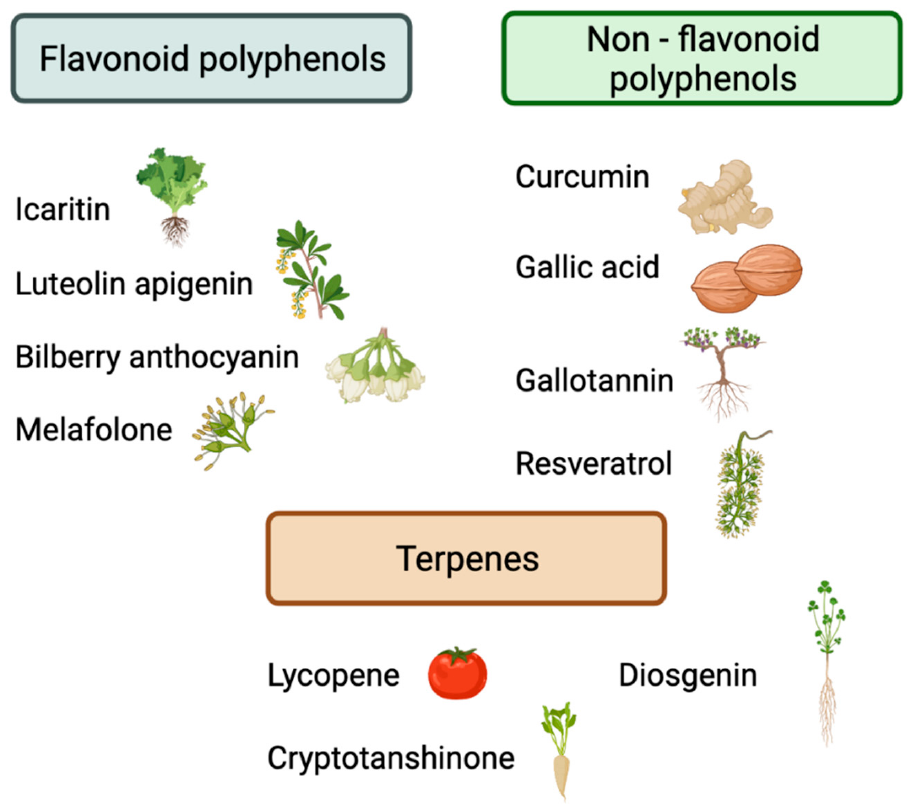
Figure 2. Schematic figure reporting the main phytochemicals which have been tested as modulators of immune checkpoint inhibitors in cancer patients. The flavonoid polyphenols include, among others, icaritin, luteolin, bilberry anthocyanin, and melafolone. Non-flavonoid polyphenolic compounds include curcumin, gallic acid, gallotannin, and resveratrol, while terpenes include lycopene, diosgenin, and cryptotanshinone .